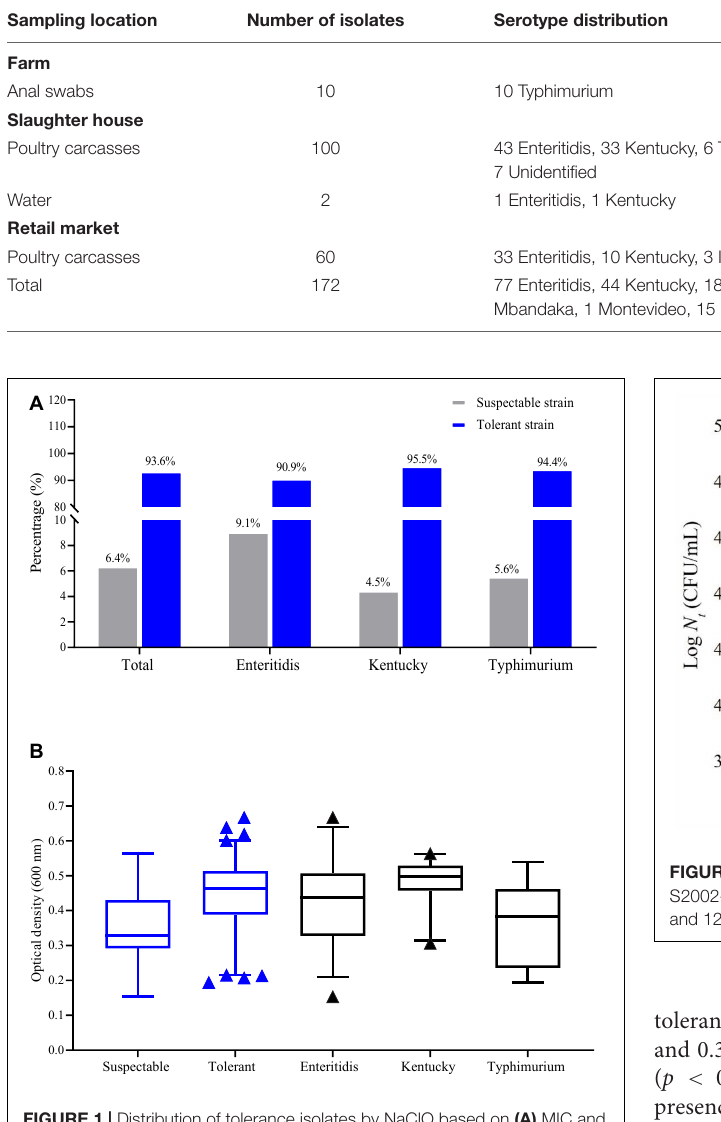
serovars in the poultry supply chain were S. Enteritidis (77/172, 44.8%), S. Kentucky (44/172, 25.6%) and S. Typhimurium (18/172, 10.5%) and these accounted for > 80% of the total serovars isolated ( Table 2 ).